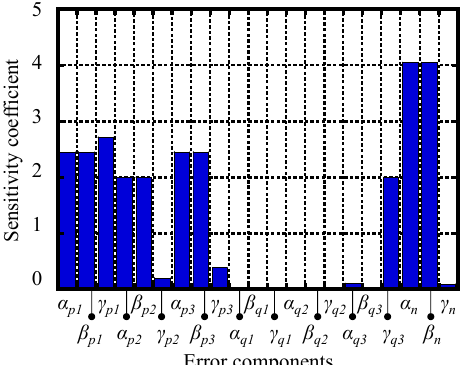
Figure 3. Error sensitivity analysis of the installation errors.